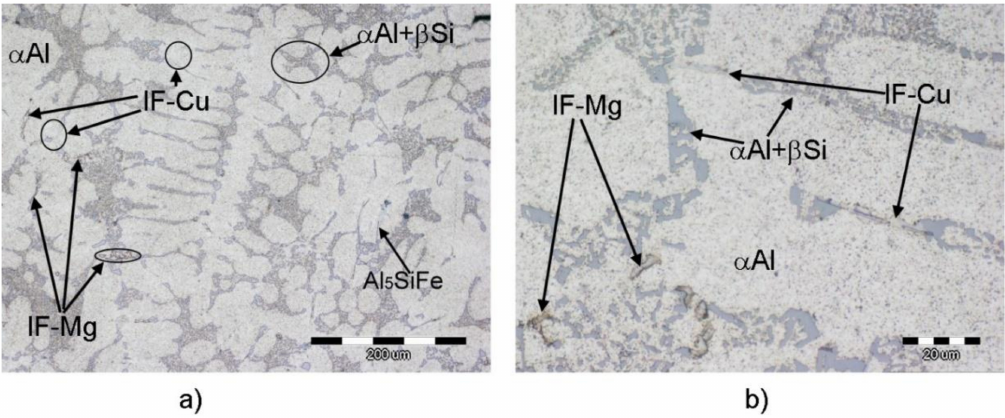
Figure 3. Micrographs of AlSi7MgCu alloy obtained by optical microscopy at di ff erent magnification: ( a ) 200 × ; ( b ) 1000 ×